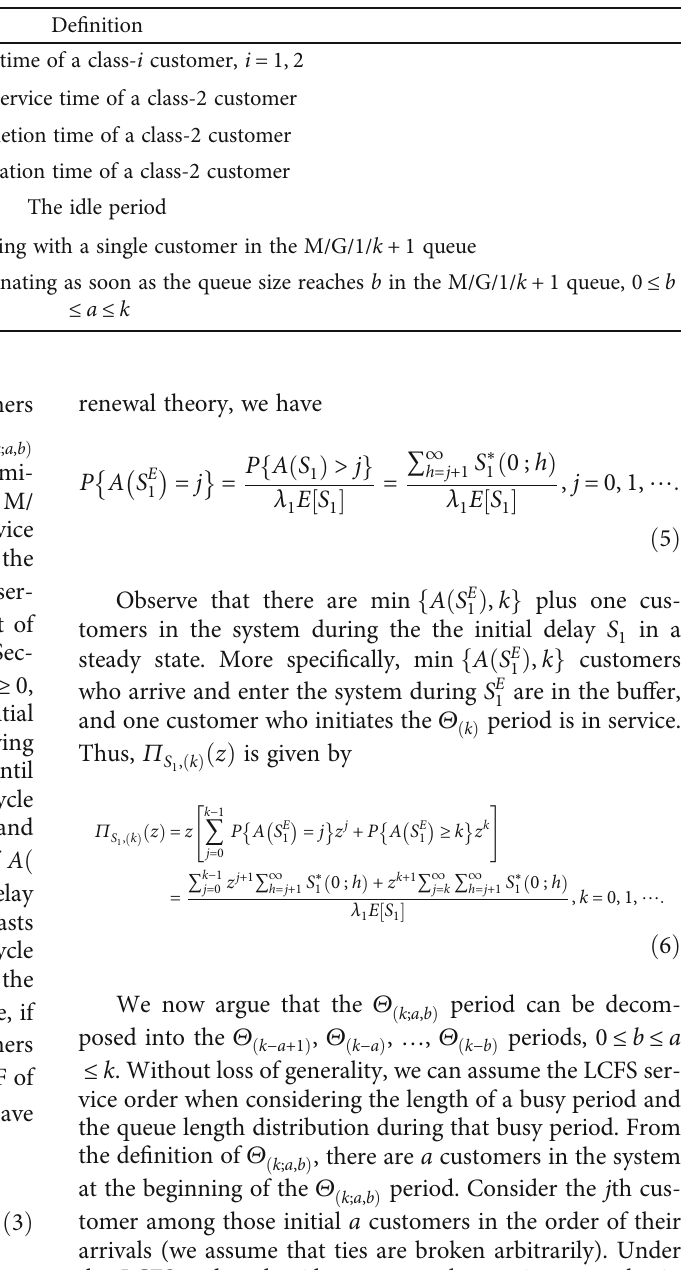
Table 1: Random variables representing a certain time